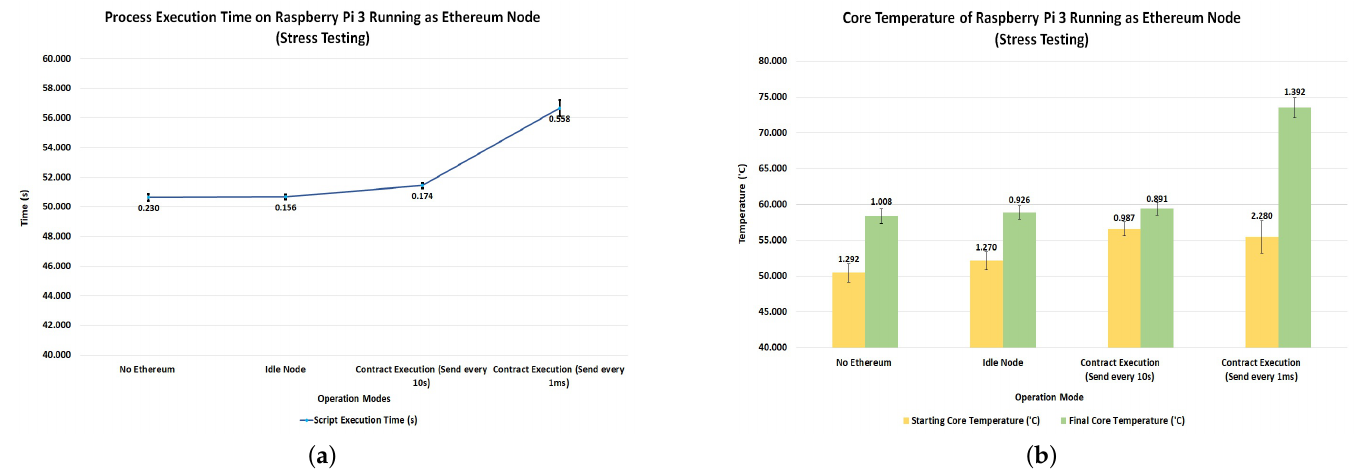
Figure 8. Stress testing results of Raspberry Pi Ethereum node: ( a ) Concurrently running Python script execution time. ( b ) Core temperature of Raspberry Pi node under stress